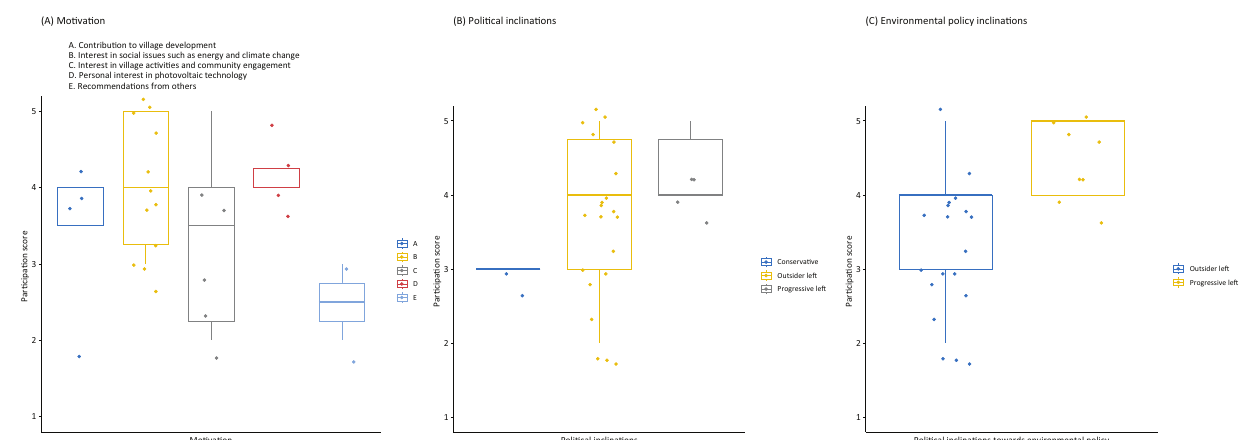
Figure 6. Participation scores by (a) motivation, (b) political inclinations, and (c) environmental policy inclinations. government officials, and corporations, they experience democratic values and internalize citizenship (Cardullo et al., 2018; Sørensen & Torfing, 2011). The improve‐ ment of knowledge through living lab activities